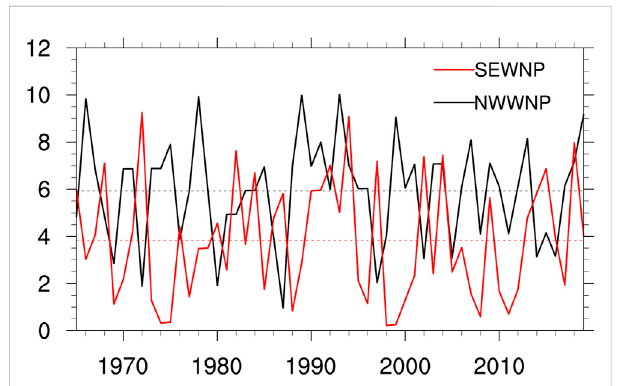
FIGURE 2 Time series of TC genesis frequency in the SEWNP (red line) and NWWNP (black line) in JJASON during 1965 – 2019. The dotted line denotes the average.